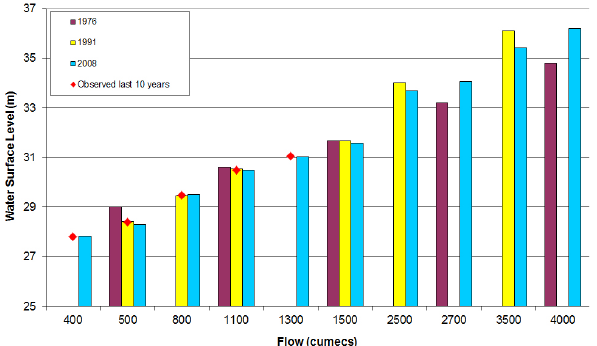
Fig. 13. Comparison for computed water levels at Sarai Baghdad station in 1976, 1991 and 2008.